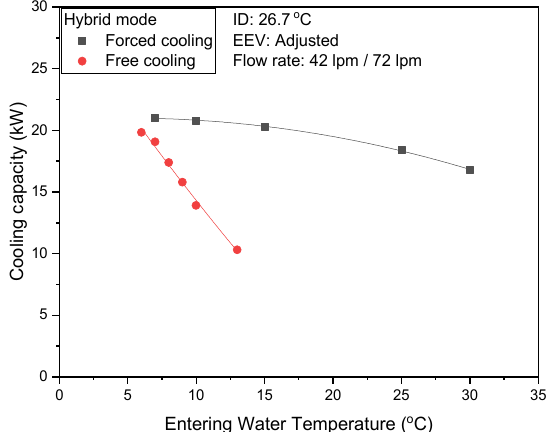
Figure 15. Cooling capacity according to EWT in hybrid mode.